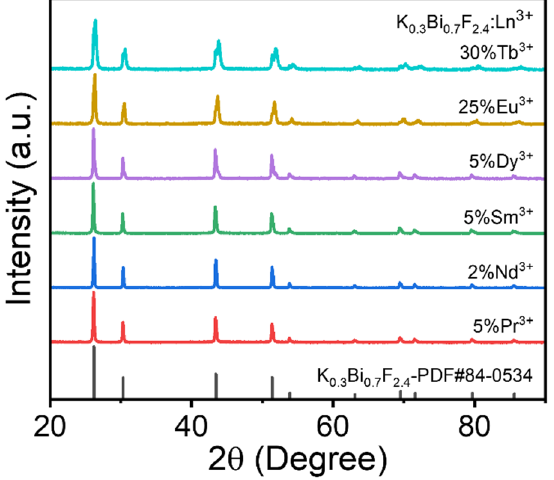
Figure 2. XRD patterns of the doped KBF nanocrystals.